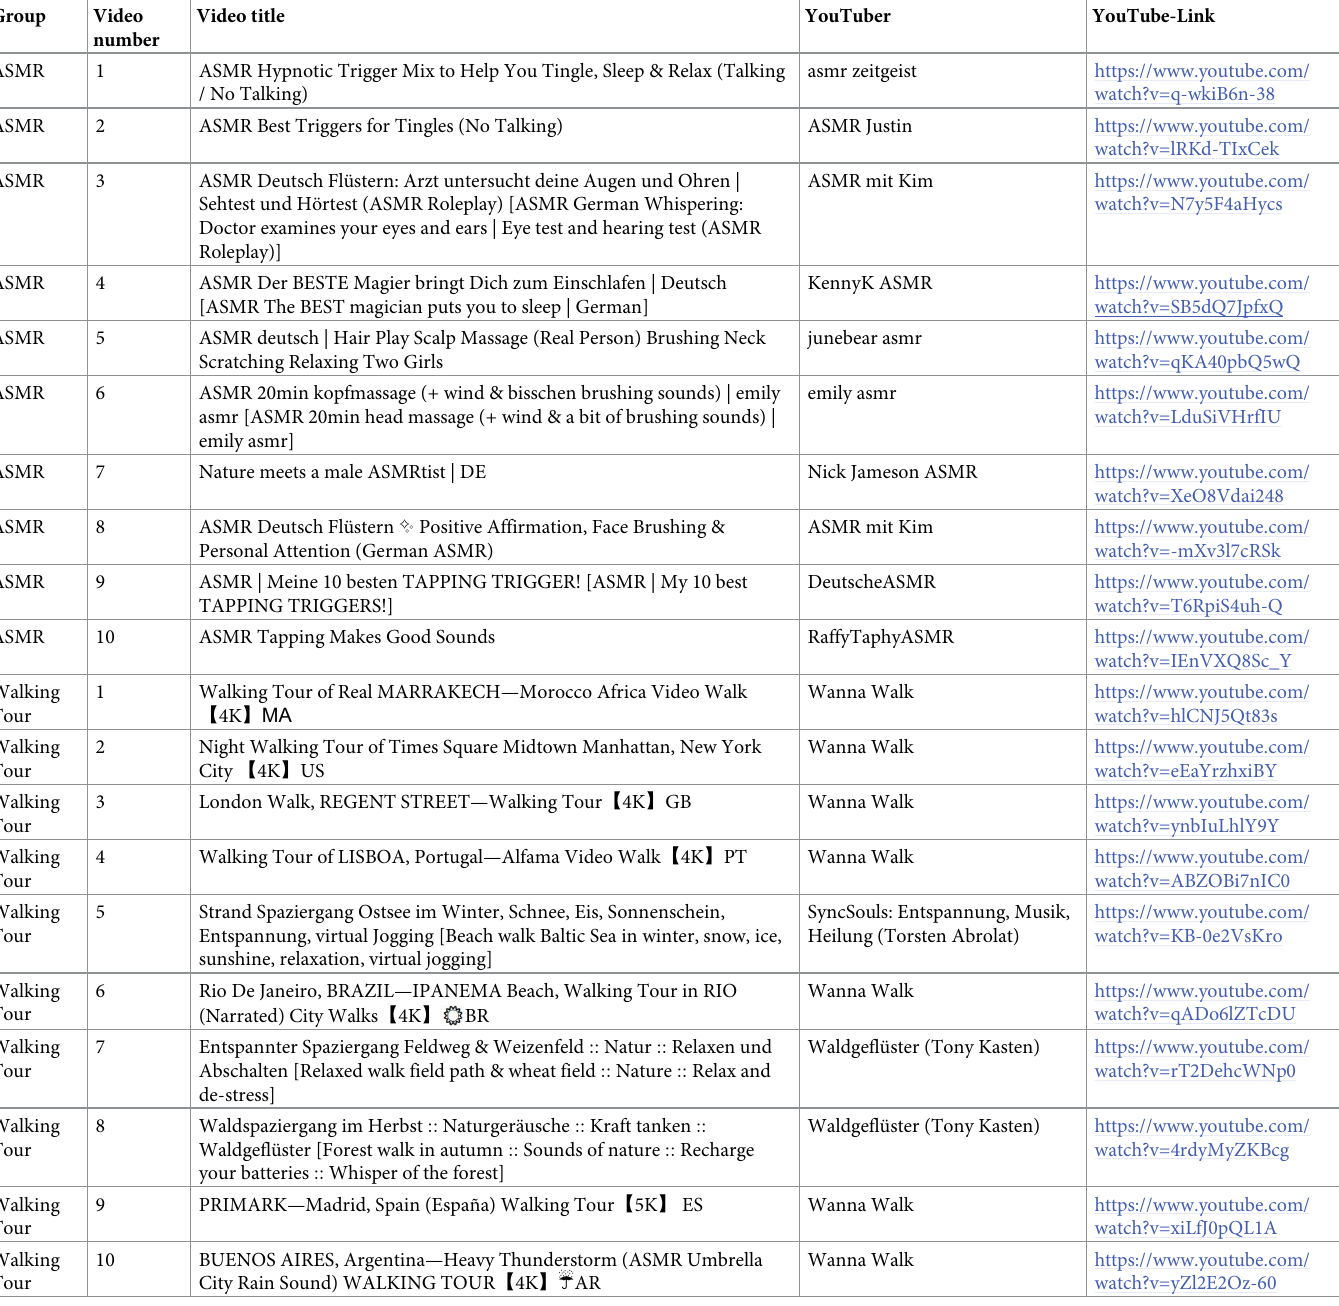
Table 2. List of all videos used in the respective group including YouTube link.